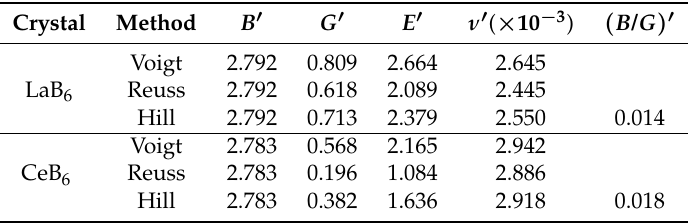
Table 6. Pressure derivatives of polycrystalline elastic modulus B (cid:48) (bulk modulus), G (cid:48) (shear modulus), and E (cid:48) (Young’s modulus), and Poisson’s ratio ν (cid:48) of LaB 6 and CeB 6 . Crystal Method B (cid:48) G (cid:48) E (cid:48) ( B / G )